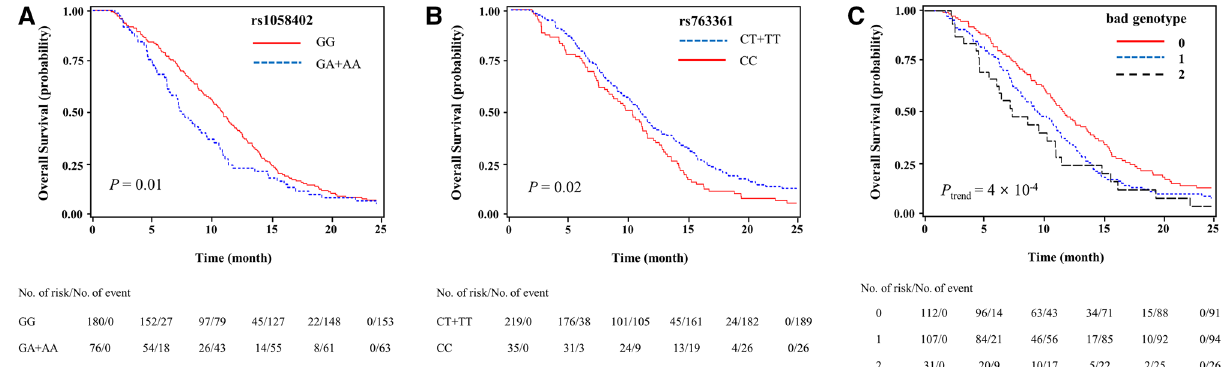
Figure 2. Kaplan–Meier plots for overall survival according to polymorphisms. ( A ) CD155 rs1058402, ( B ) CD226 rs763361, and ( C ) combined bad genotypes. P values were calculated using multivariate Cox proportional hazard